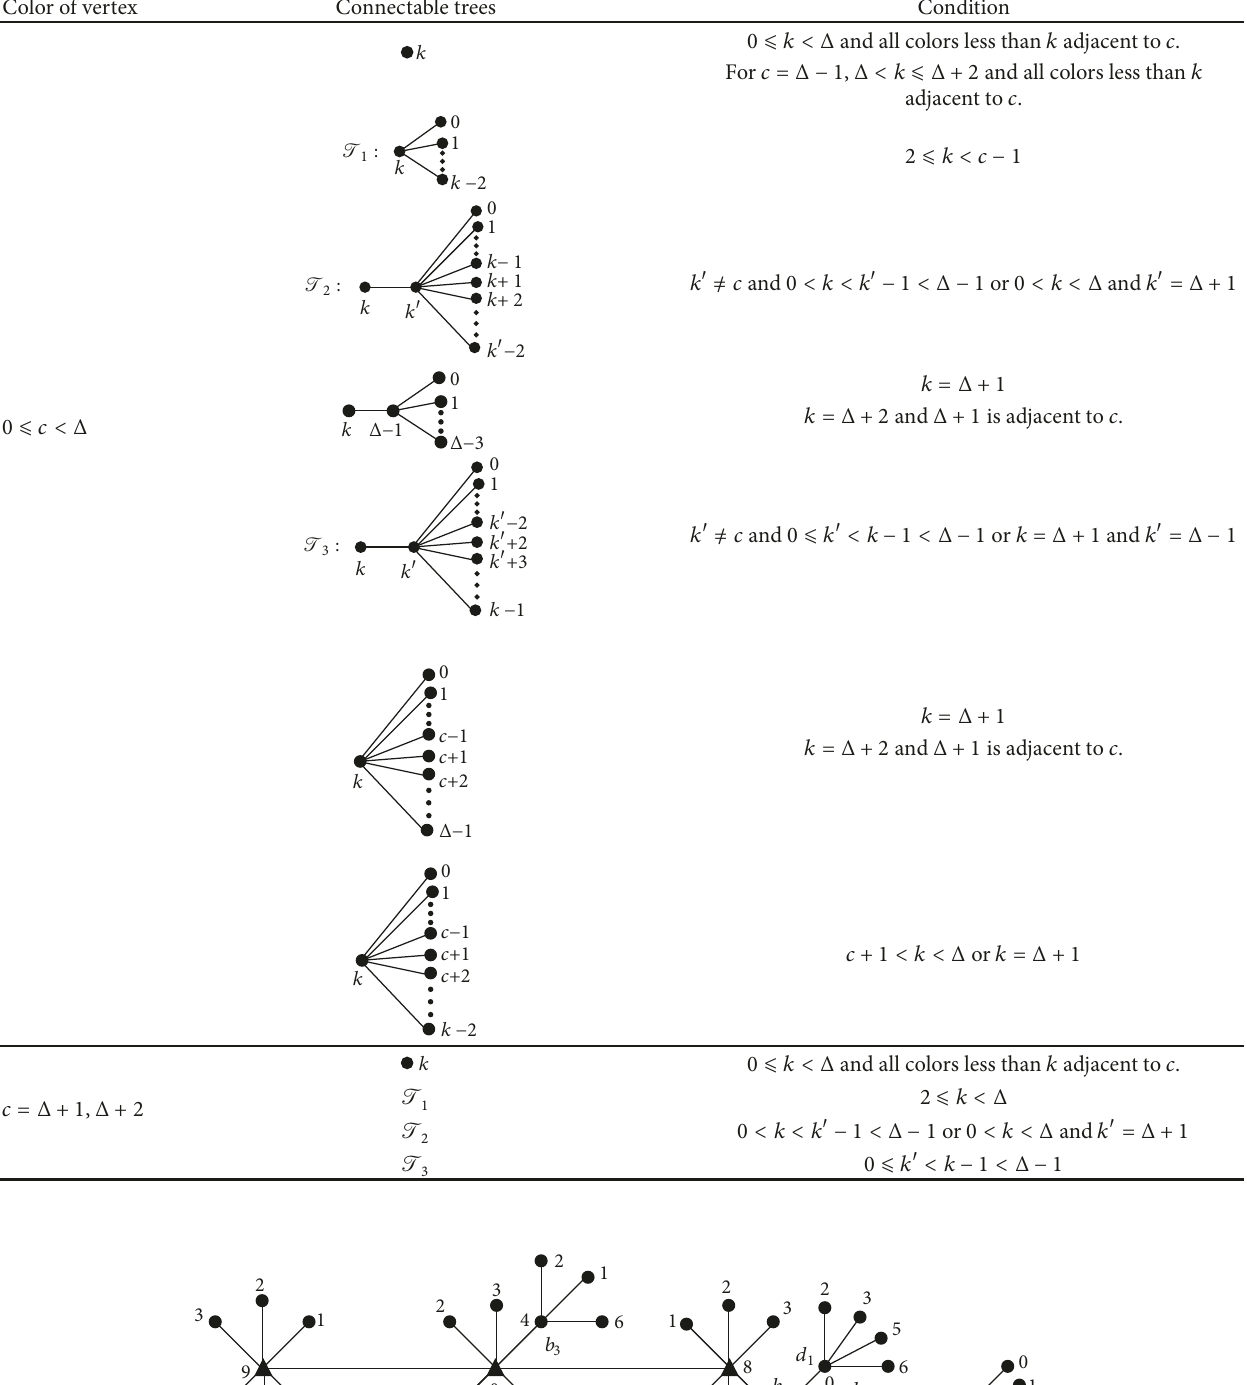
Table 5: Trees connectable for a vertex colored 𝑐 in a one-hole tree with Δ as the hole. Color of vertex Connectable trees